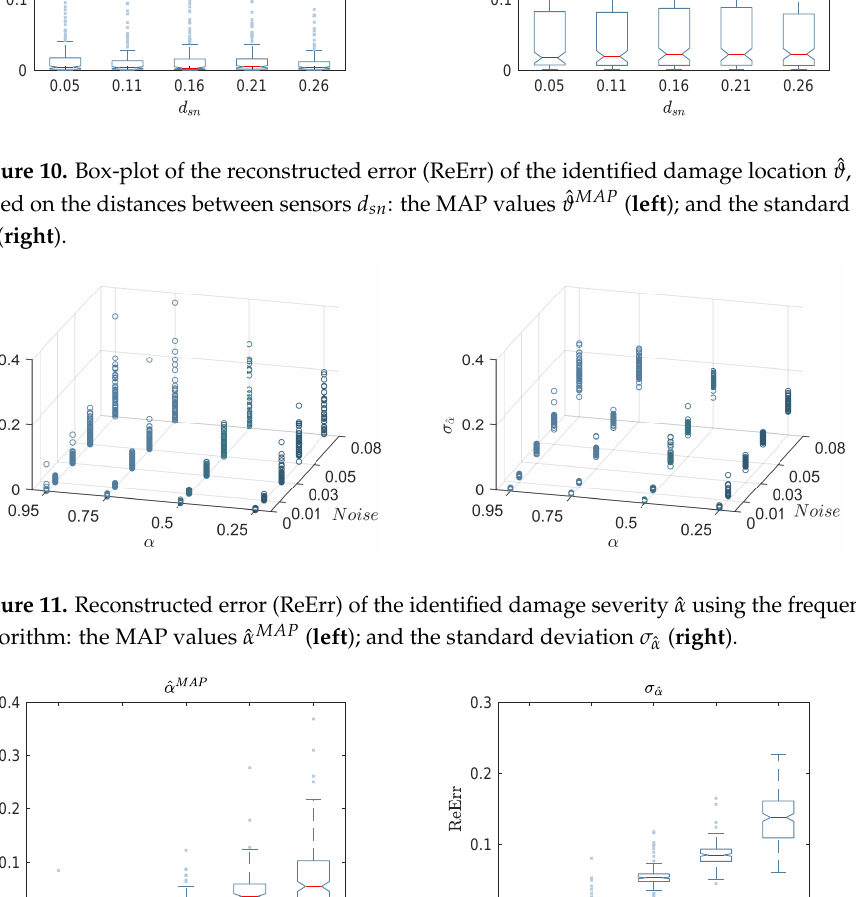
Figure 12. Box-plot of the reconstructed error (ReErr) of the identified damage location ˆ α , clas- sified based on noise level: the MAP values ˆ α MAP ( left ); and the standard deviation σ ˆ α ( right